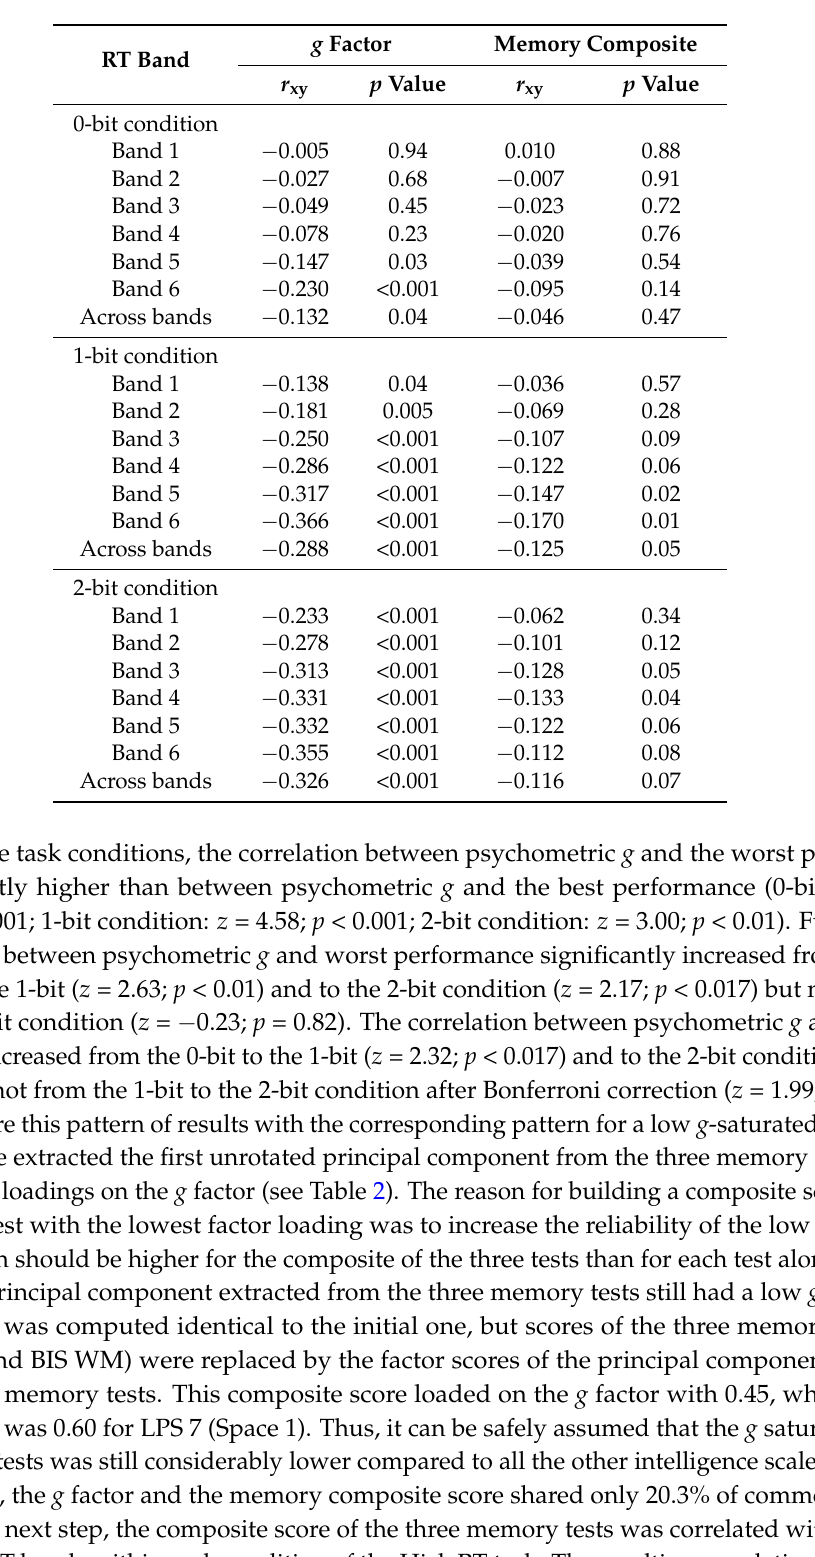
Table 4. Pearson correlations ( r xy ) between mean RT of each band and across all six bands and the g factor and the memory composite as a high and low g -saturated measure of intelligence,